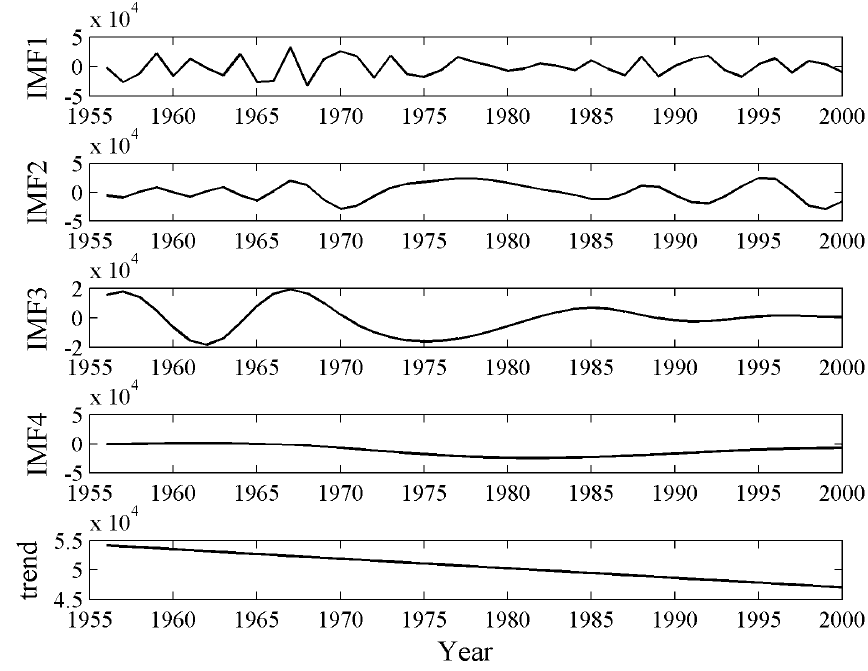
Figure 7. EMD results of runoff series for Zhaishang station.